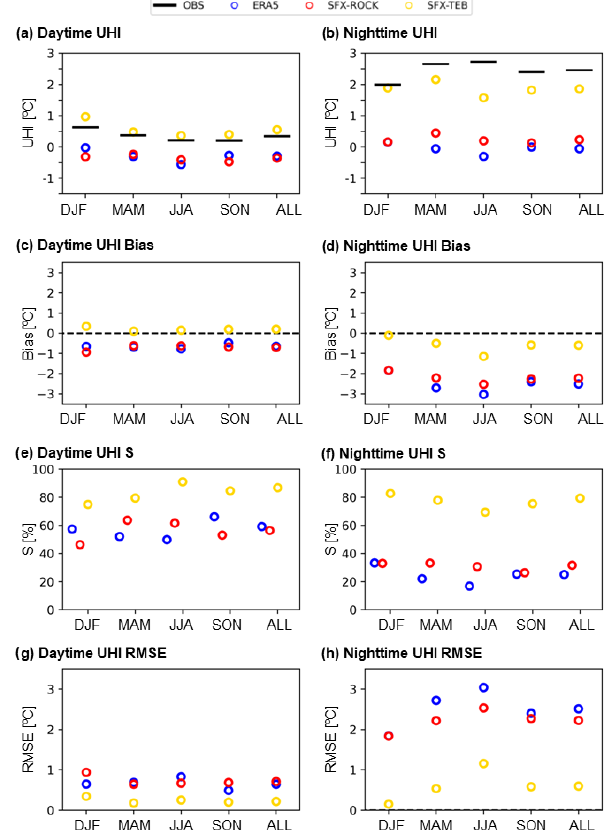
Figure 10. Annual and seasonal average Parisian UHI magnitude computed over the 2004–2018 period during the (a) daytime and (b) nighttime. The corresponding annual and seasonal average bias for the daytime is represented in panel (c) and for the nighttime in panel (d) . The corresponding annual and seasonal S score is rep- resented in panel (e) for the daytime and panel (f) for the night- time. The corresponding annual and seasonal RMSE is represented in panel (g) for the daytime and panel (h) for the nighttime. The observed UHI is represented by black lines, ERA5 by blue markers, SFX-ROCK by red markers, and SFX-TEB by yellow